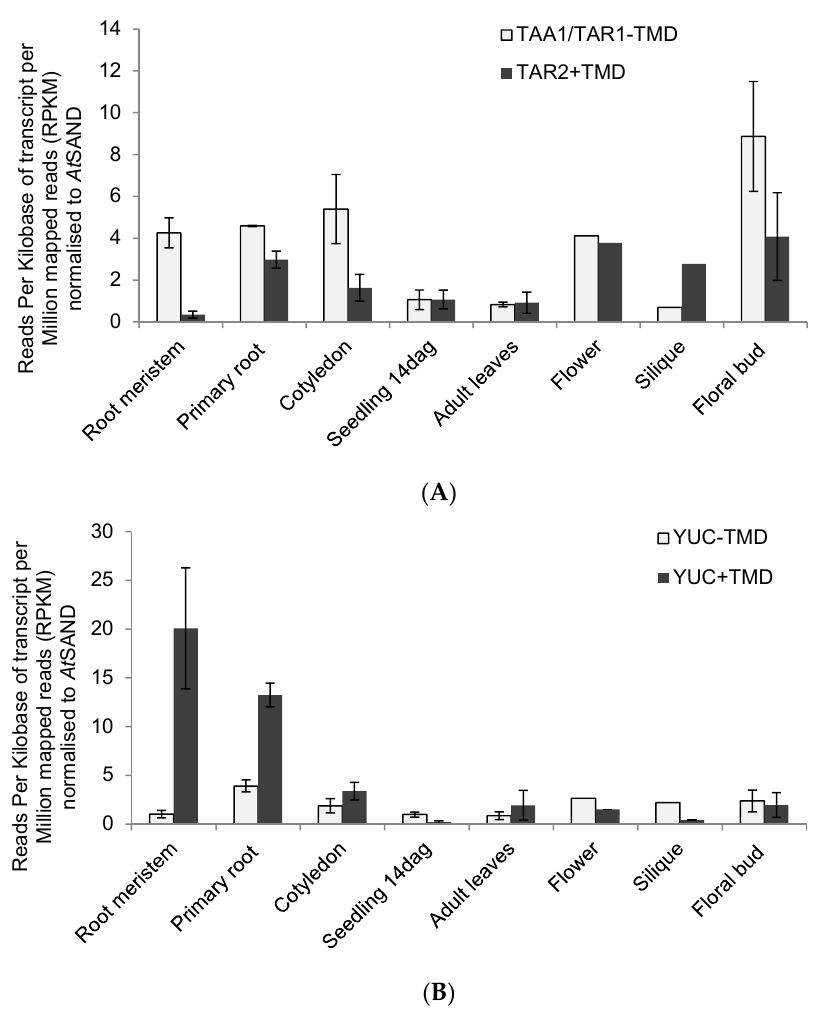
Figure 7. Tissue-specific distribution of TAA/TAR and YUC transcripts with and without predicted TMD. ( A ) RNA sequencing transcript analysis for TAA/TAR proteins without TMD (TAA1, TAR1) and with TMD prediction (TAR2) in root meristem, primary root, cotyledon, seedling 14 dag, adult leaves, flower, silique and floral bud tissue (Table 3 and see Material and Methods section). Data is given as RPKM (reads per kilobase of transcript per million mapped reads) and was normalised to the reference gene AtSAND (At2g28390); ( B ) RNAseq transcript analysis for YUC proteins without TMD (YUC1, 2, 4, 6, 10, 11) and with TMD prediction (YUC3, 5, 7, 8, 9) in root meristem, primary root, cotyledon, seedling 14 dag, adult leaves, flower, silique and floral bud tissue (Table 3 and see Material and Methods section) Data is given as RPKM (reads per kilobase of transcript per million mapped reads) and was normalised to the reference gene AtSAND (At2g28390).